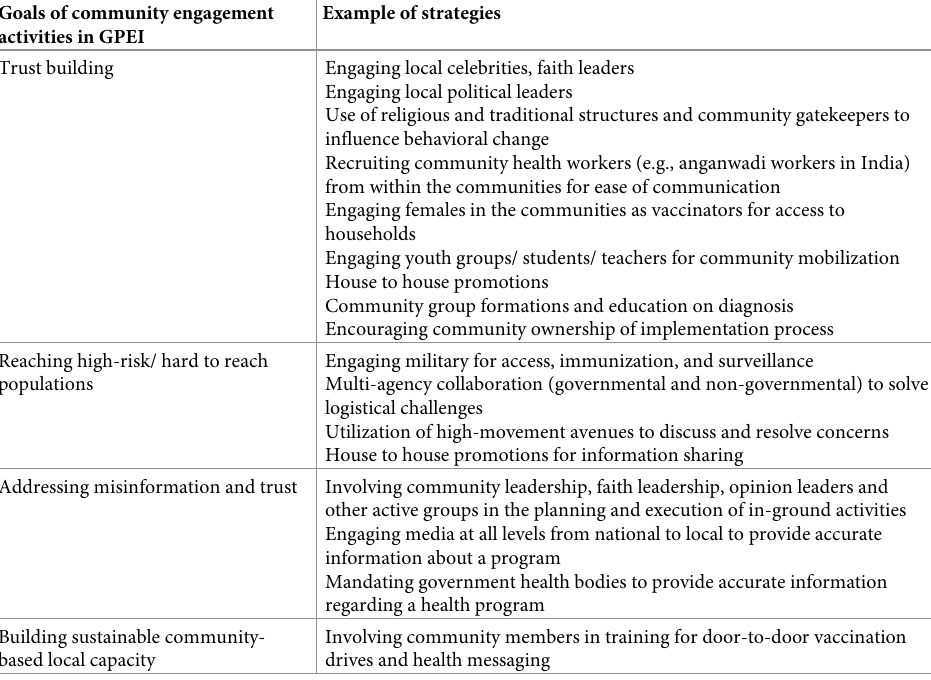
Table 2. Community engagement activities in GPEI as reported by